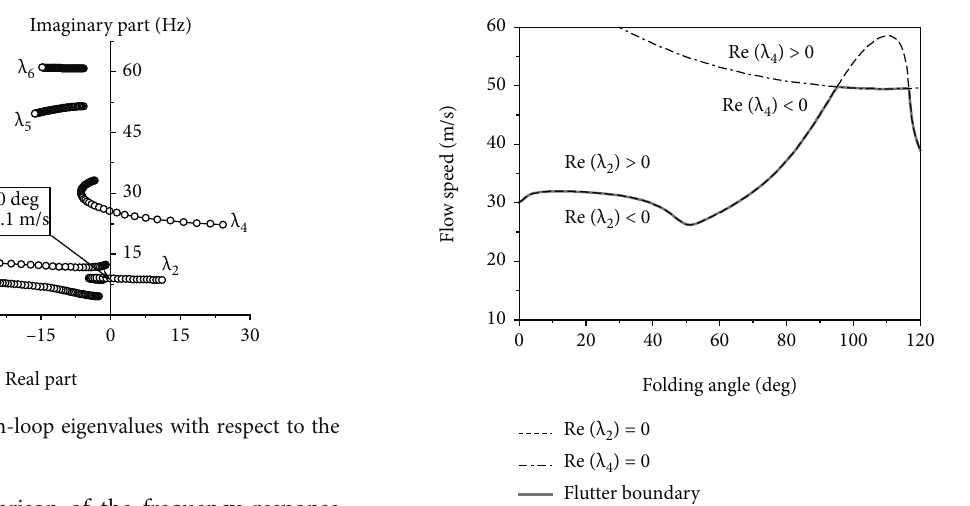
Figure 10: Frequency responses for varying parameters. (a) Variation with respect to the folding angle. (b) Variation with respect to the fl ow speed.